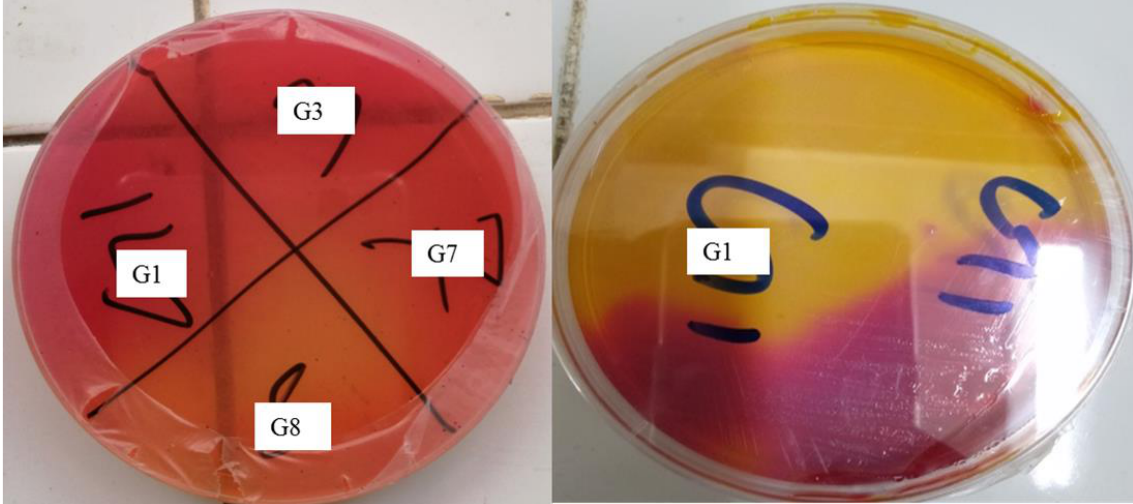
Figure 1. Color production indicating L-Glutaminase-producing bacterial isolates from an expired Glutamine sample. Table 1. Screening of bacterial isolate for glutaminase production by zone of hydrolysis.